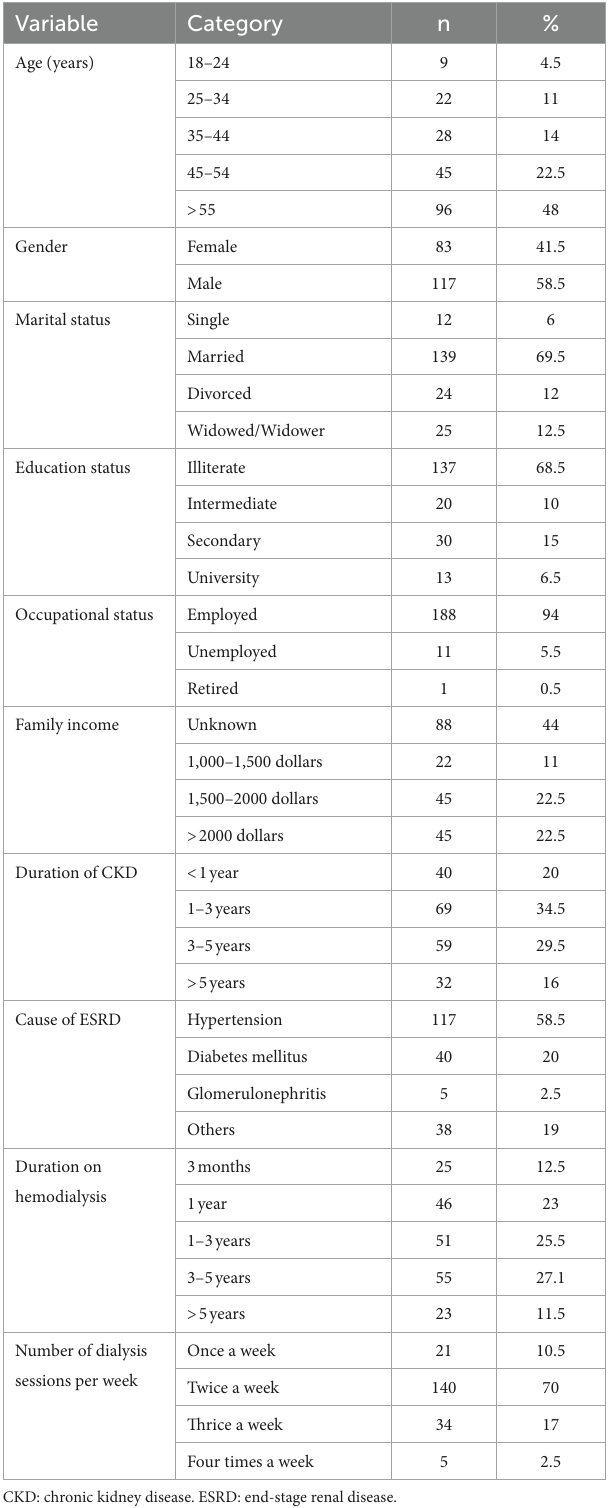
TABLE 1 Sociodemographic characteristics of the study participants ( n =